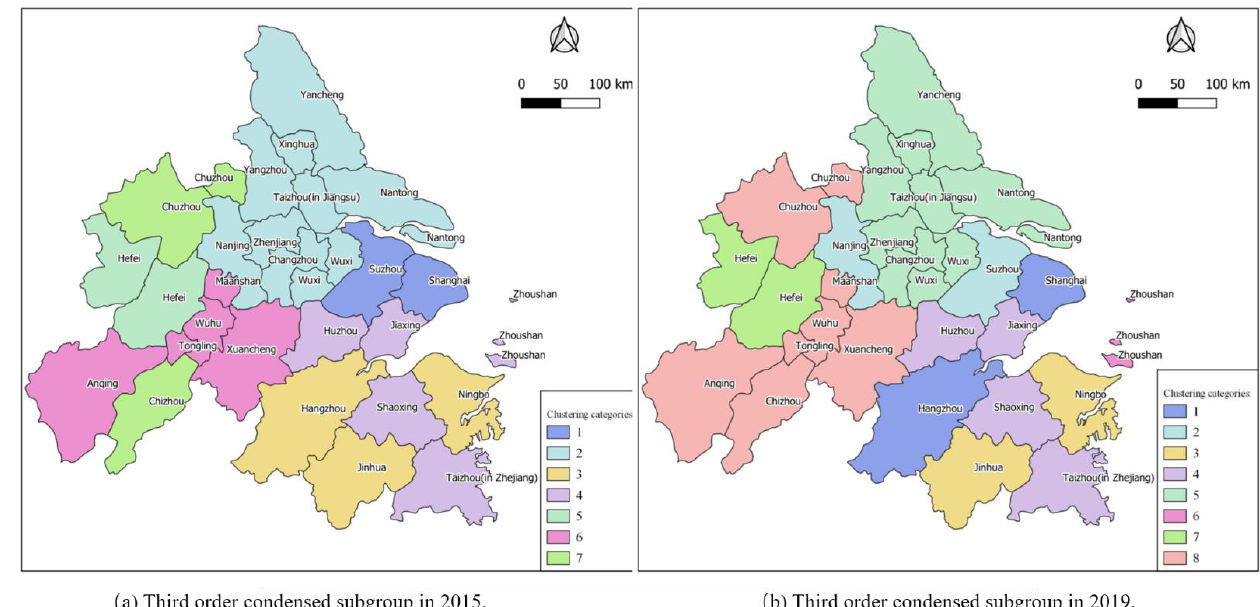
Figure 11. Third order condensed subgroup: (a) 2015; (b)